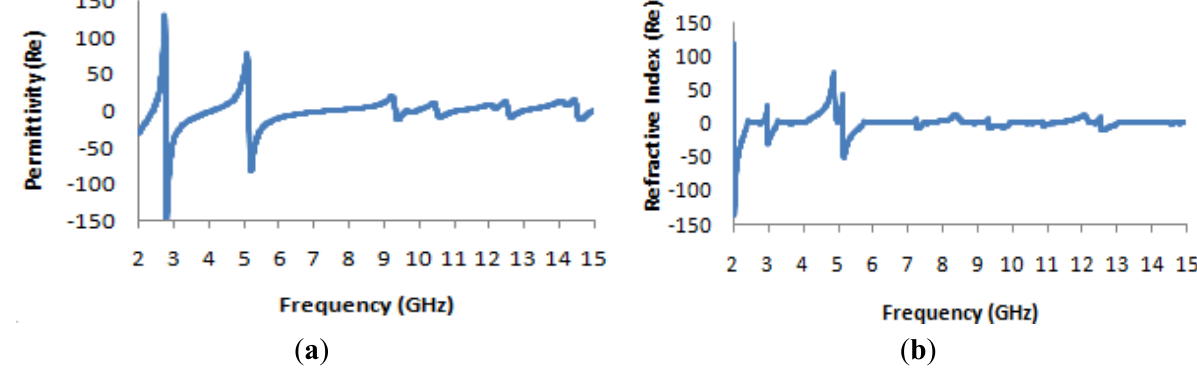
Figure 8. ( a ) The real value of permittivity vs. the frequency for the 1 × 1 array of the unit structure; ( b ) the real value of the refractive index vs. frequency for the 1 × 1 array of the unit structure.